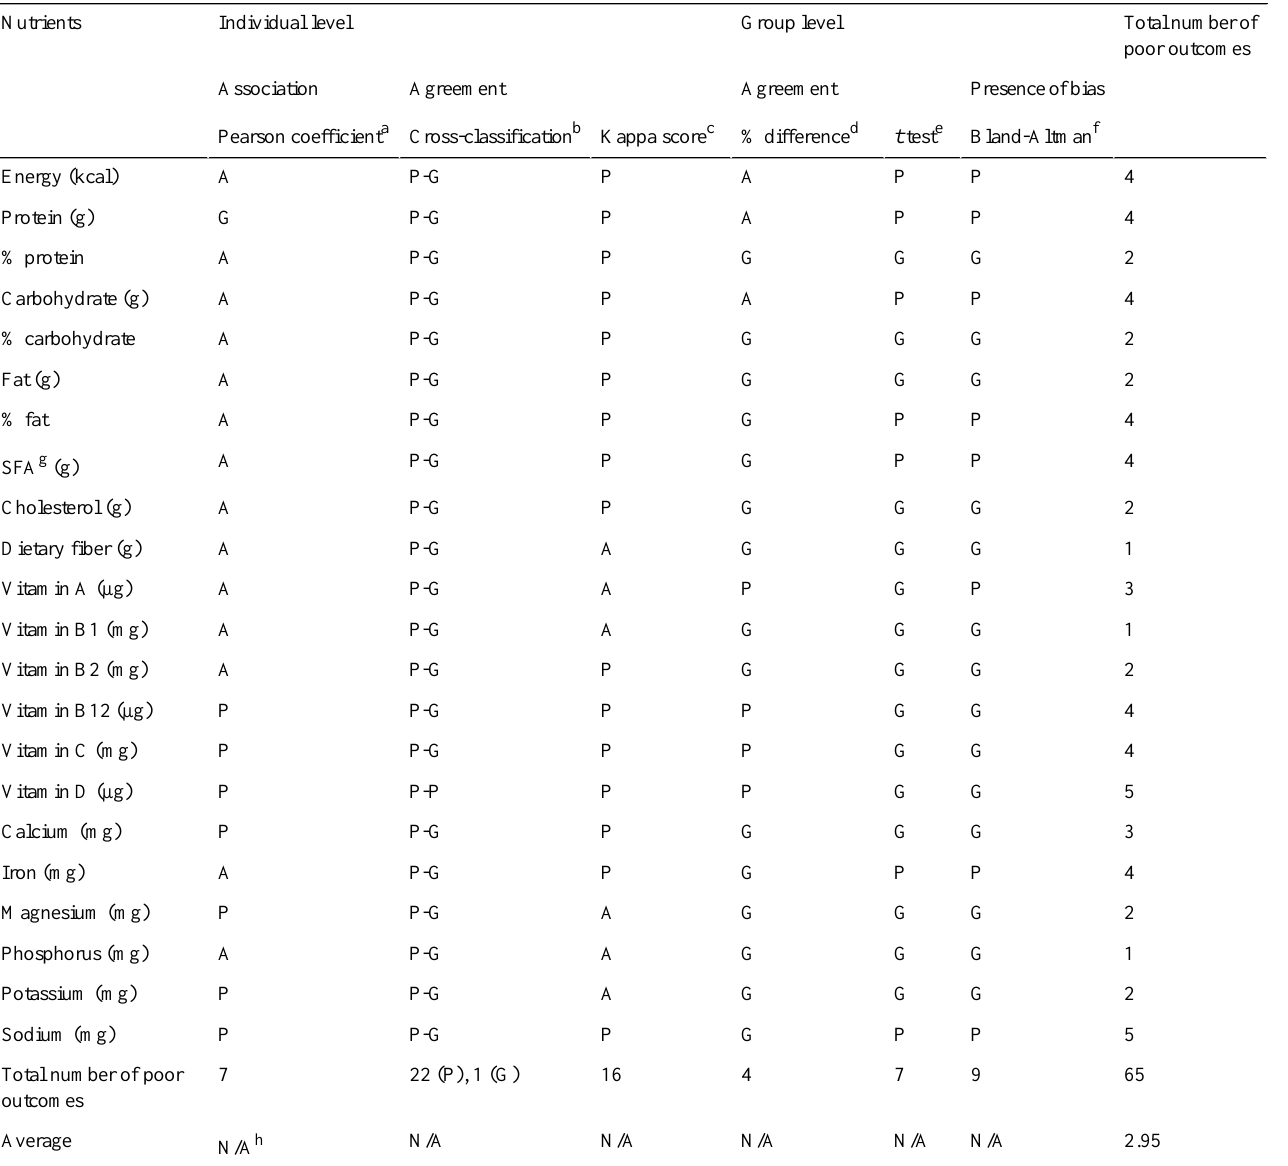
Table 3. Validity analysis of the Keenoa application (Keenoa-dietitian), based on criteria levels for good (G), acceptable (A), and poor (P) outcomes.